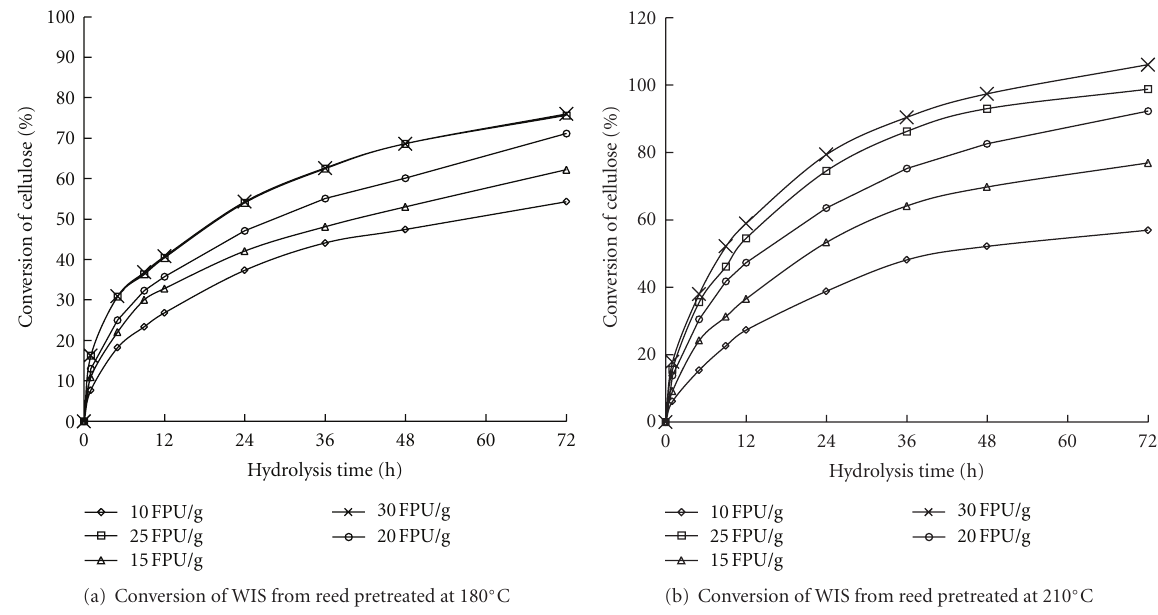
Figure 5: Enzymatic hydrolysis of WIS from reed in the LHW pretreatment at 180 ◦ C and 210 ◦ C with respect to di ff erent cellulase loadings.